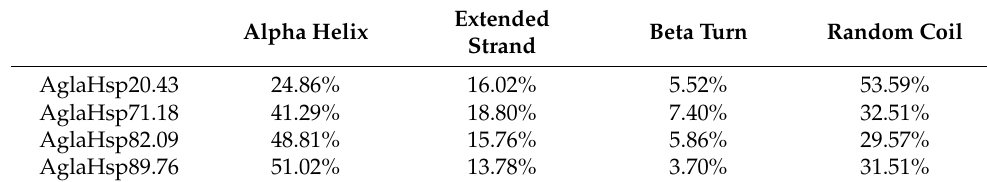
Table 2. Secondary structure analysis of AglaHsps.